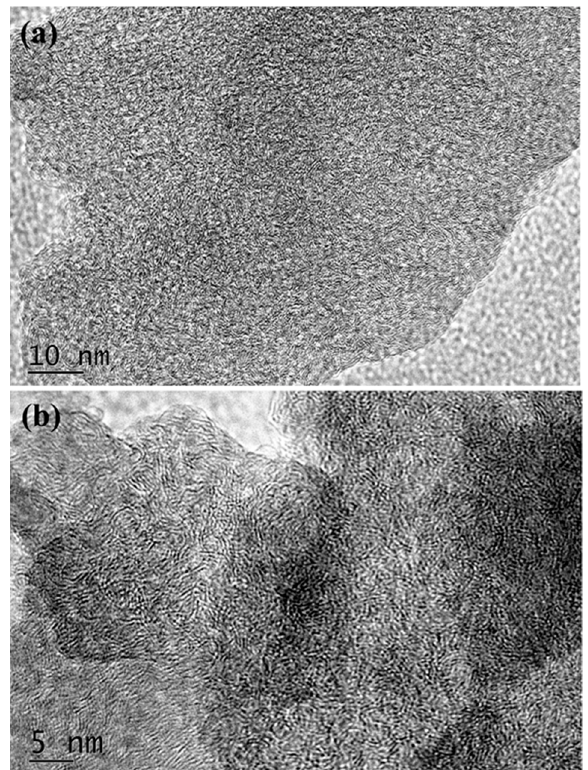
Figure 6. The SEM images of GMC samples. ( a ) GMC sample prepared in a tubular furnace at 800 °C. ( b ) GMC sample prepared in a tubular furnace at 1000 °C. ( c ) GMC sample prepared in a tubular furnace at 1200 °C. ( d ) A close view of a GMC sample prepared in a tubular furnace at 1200 °C. In the GMC sample, prepared at 800 °C, there are more holes. However, with the temperature increase the GMC samples become more compact and uniform.